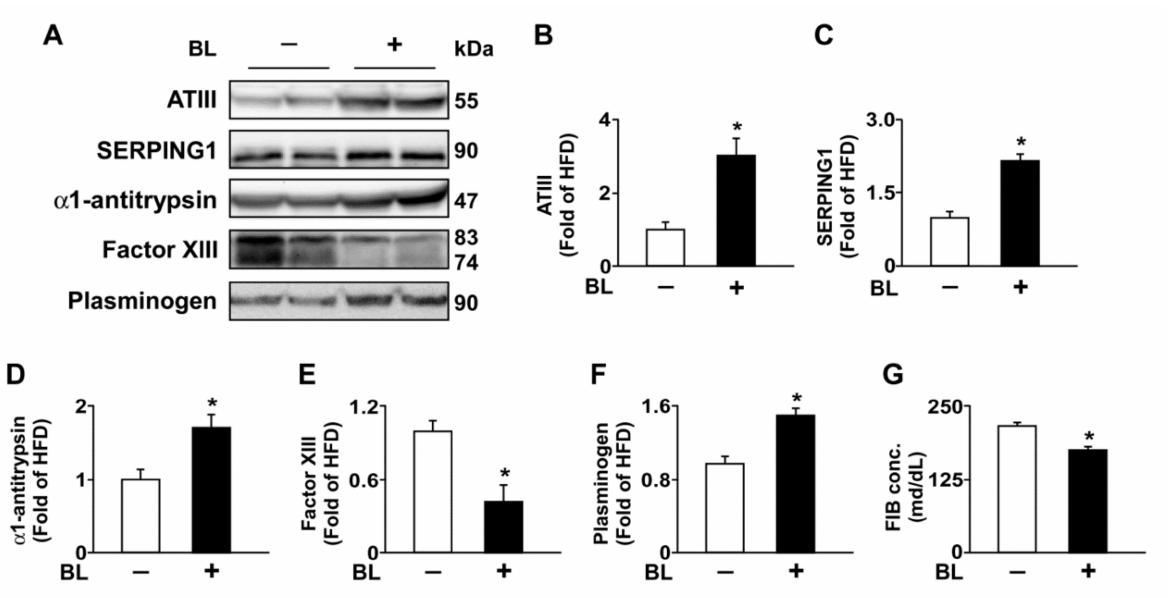
Figure 4. Effect of BL on the expression of coagulation factors in the plasma of HFD-fed mice. Eight-week-old C57BL/6 mice were fed with HFD and administered PBS or BL (20 mg/kg/day) for 12 weeks. The plasma was collected and subjected to Western blot analysis or enzyme-linked immunoassay (ELISA) assay. ( A – F ) The protein levels of ATIII, SERPING1, α 1-antitrypsin, and plasminogen. ( G ) The levels of FIB were assessed by an ELISA kit. Data represent the mean ± SEM from 10 mice. * p < 0.05 vs. HFD alone group. Abbreviations: ATIII, antithrombin III; BL, bromelain; HFD, high-fed diet; SERPING1, serpin family G member